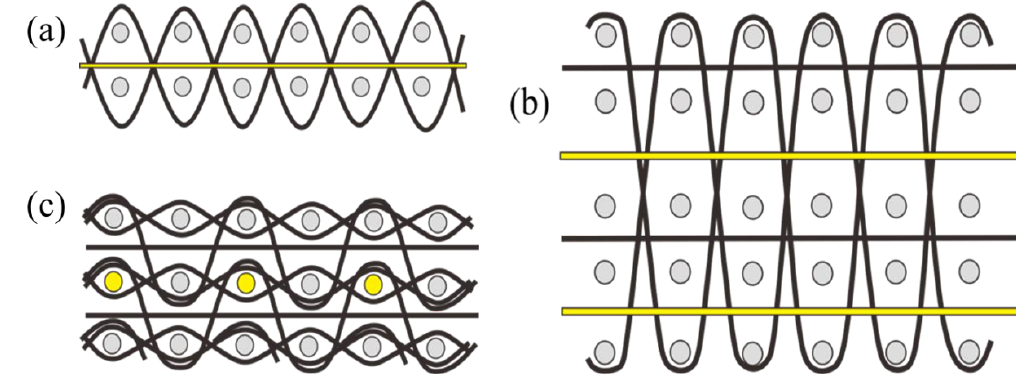
Figure 8. Optical fibers in multilayer woven structures: ( a ) optical fiber as a weft yarn between two layers of warp yarns; ( b ) optical fibers applied between any two warp layers in a multilayer interlacing structure; ( c ) optical fibers as warp yarns in a multilayer hollow structure.